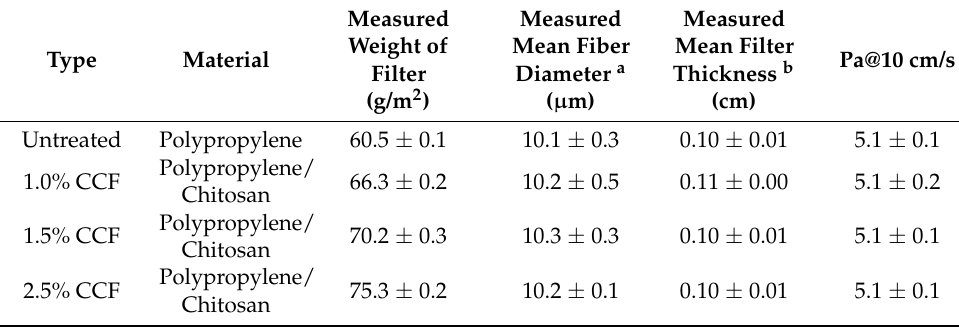
Table 1. Fiber characteristics of original filters and